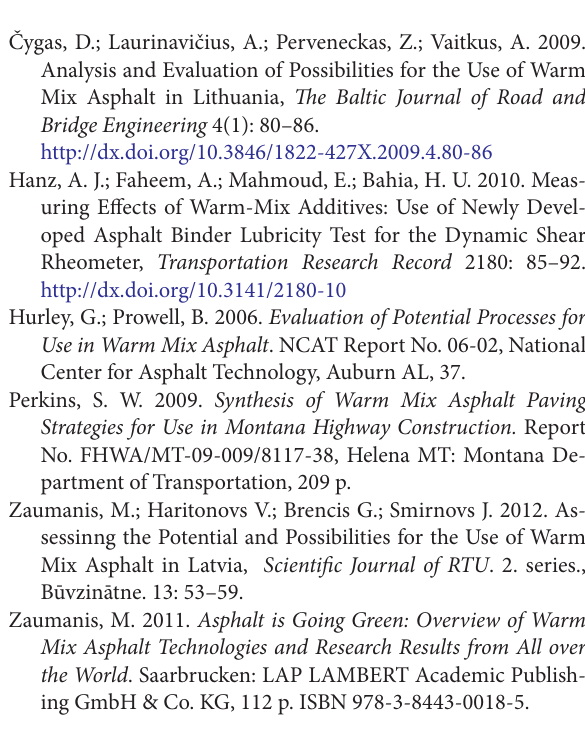
WMXa) Fig. 11. Max strain for dynamic creep test: a – Marshall specimens; b – Gyratory specimens: Reference; Sasobit; Rediset